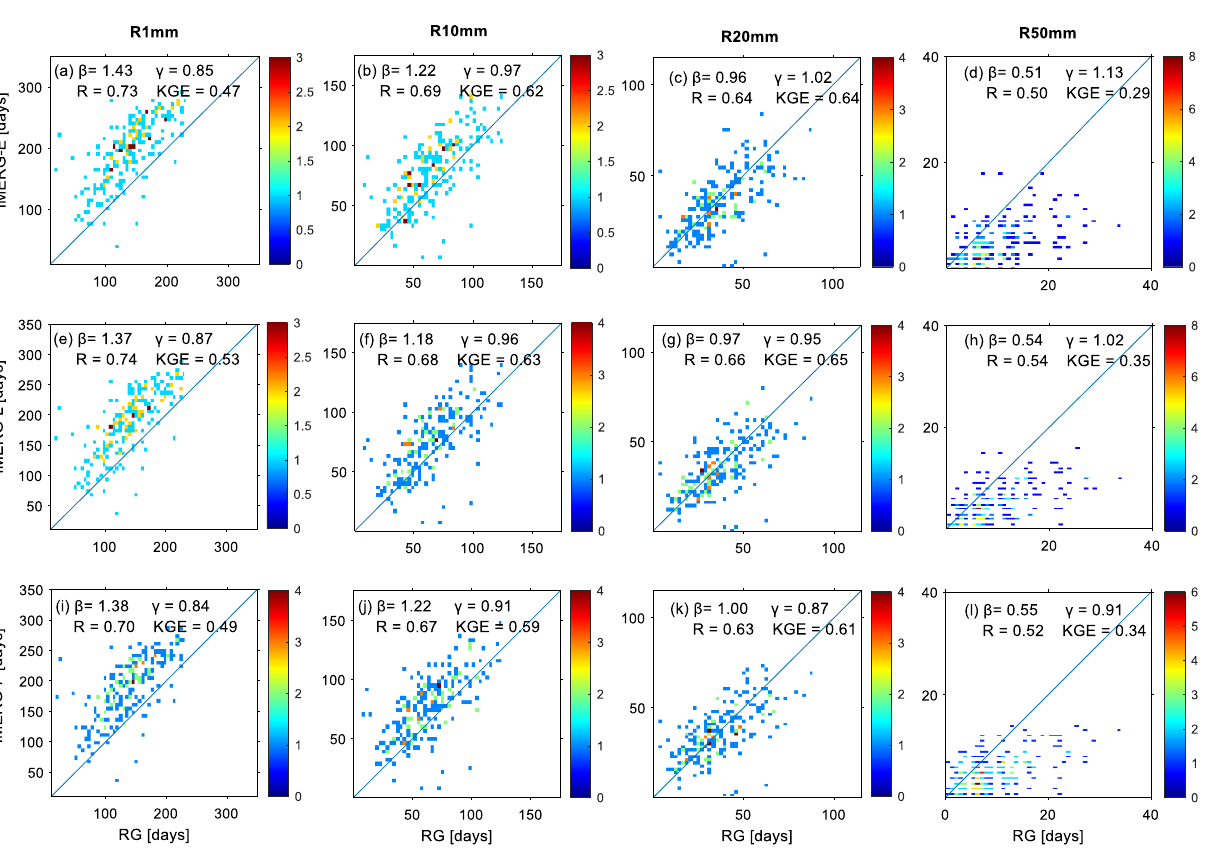
Figure 8. Scatter plot of precipitation-frequency-based indices from IMERG and RG observation, namely, R1mm ( a , e , i ), R10mm ( b , f , j ), R20mm ( c , g , k ), and R50mm ( d , h , l ), for IMERG-E (top), L (middle) and F (bottom). The color indicates the number of data